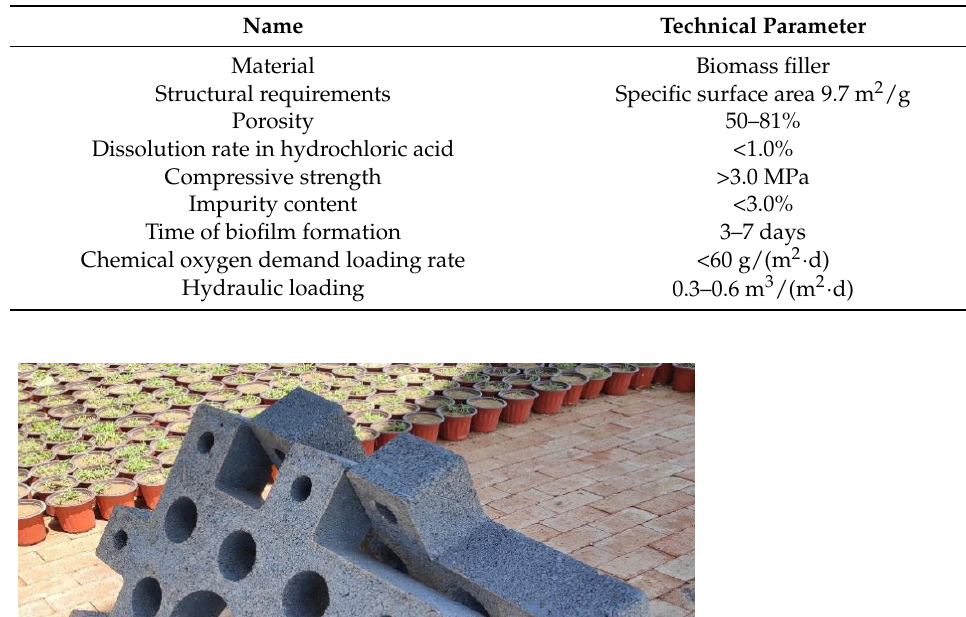
Table 1. Technical parameters of the biomass module fillers.